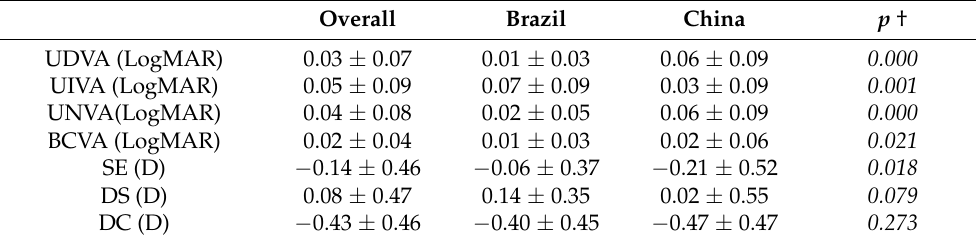
Table 2. Mean 3-month postoperative visual acuity and refractive